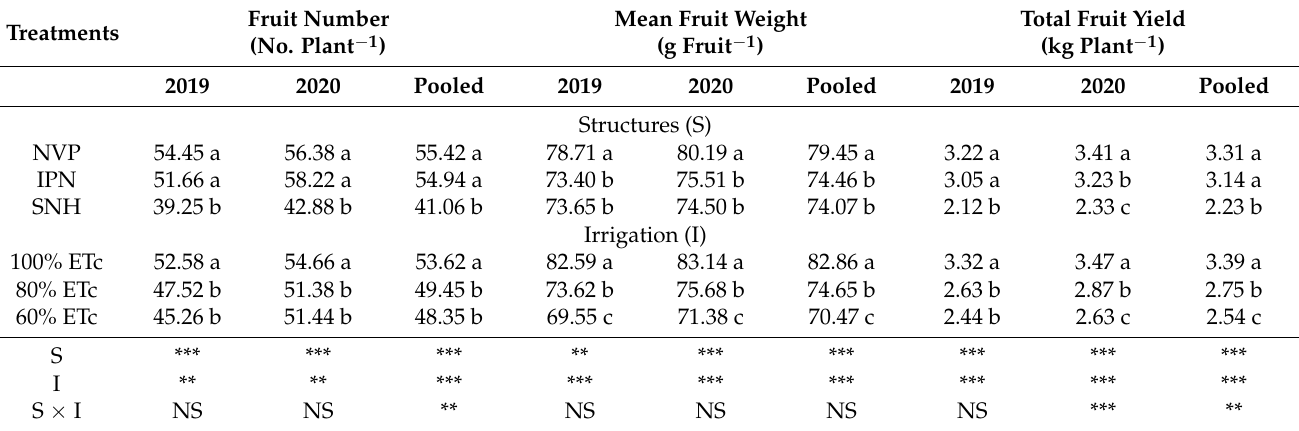
Table 9. Effect of protected structures and irrigation levels on yield parameters of